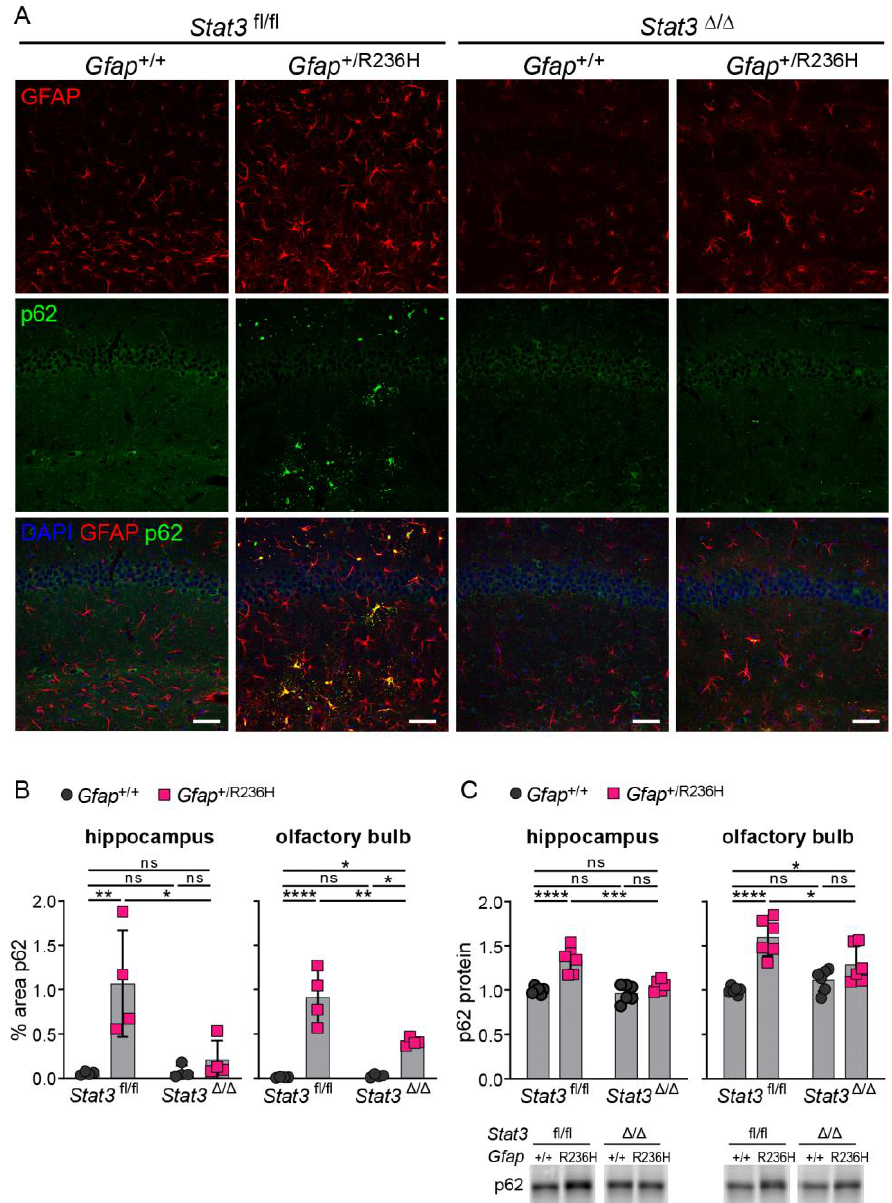
Figure 8. p62/SQSTM1 expression and protein aggregation in AxD model mice after inducing genetic knockout of Stat3 in astrocytes. ( A , B ) Immunofluorescence labeling of p62 and GFAP in hippocampus ( A ), and quantitation of percent area ( B ) in hippocampus and olfactory bulb from Gfap +/R236H mice and Gfap +/+ littermate controls (3 months of age) derived from the same Stat3 fl/fl , CreER T2 genetic cross and tamoxifen treatment schedule as shown in Figure 7A. Stat3 alleles in animals expressing the Aldh1l1 -CreER T2 transgene are indicated as Δ (Stat3 Δ/Δ ). ( C ) Quantification of p62/SQSTM1 protein in olfactory bulb and hippocampus by western analysis of a separate group of mice from the same genetic cross and treatment described in ( A , B ). C57BL/6J males and females, two- way ANOVA with Sidak’s post -tests, * p < 0.05, ** p < 0.01, *** p < 0.001, **** p < 0.0001, ns = not significant. Scale bars = 50 µm.